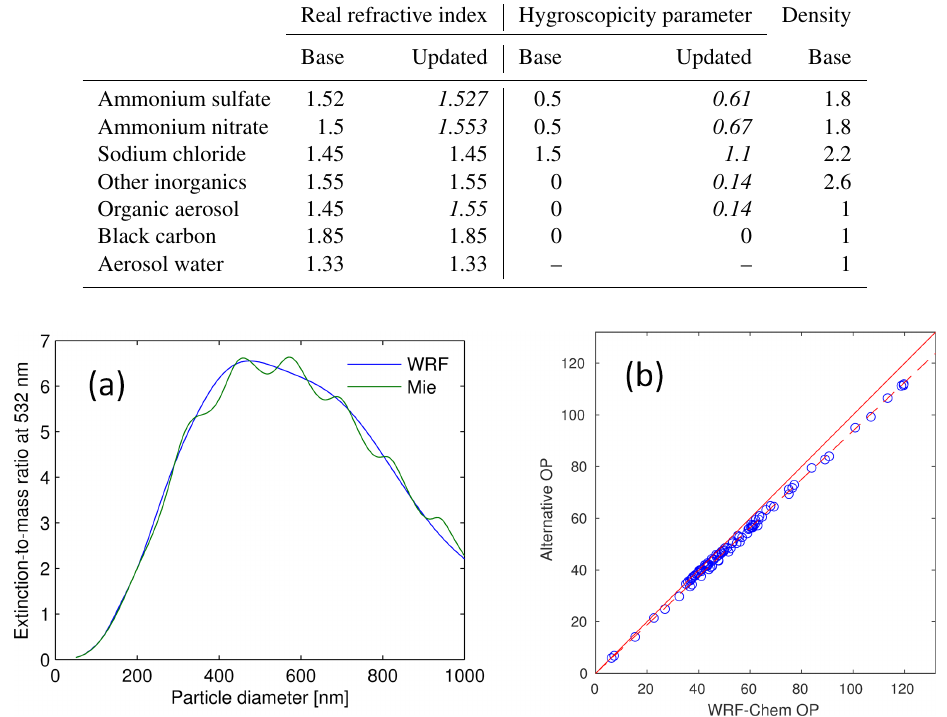
Table 2. Real refractive indexes (dimensionless), hygroscopicity parameter (dimensionless), and aerosol density (gcm − 3 ) used in the base and updated configurations. Values that changed in the updated configurations are noted in italics. Note that measured organic aerosol density was used in the closure studies.